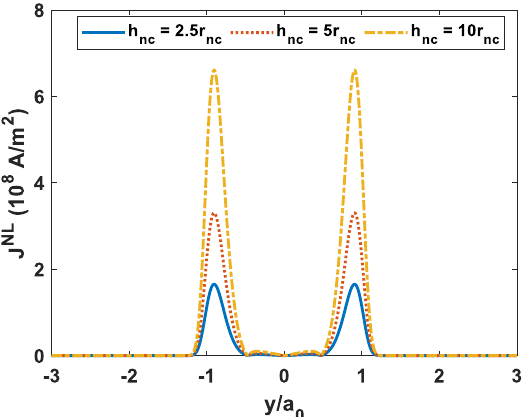
Figure 4. Variation of current density with transverse distance from the beam axis for different values of height of nanocylinders with their basal planes parallel to the electric field of laser beams, when 𝑑 𝑛𝑐 = 6𝑟 𝑛𝑐 , 𝐸 0 = 4.0 × 10 10 V/m , 𝑎 0 = 2.0 × 10 −5 m, 𝜔 ′ = 1.884 × 10 14 rad/s and 𝜔 ′′ = 1.811 × 10 14 rad/s.